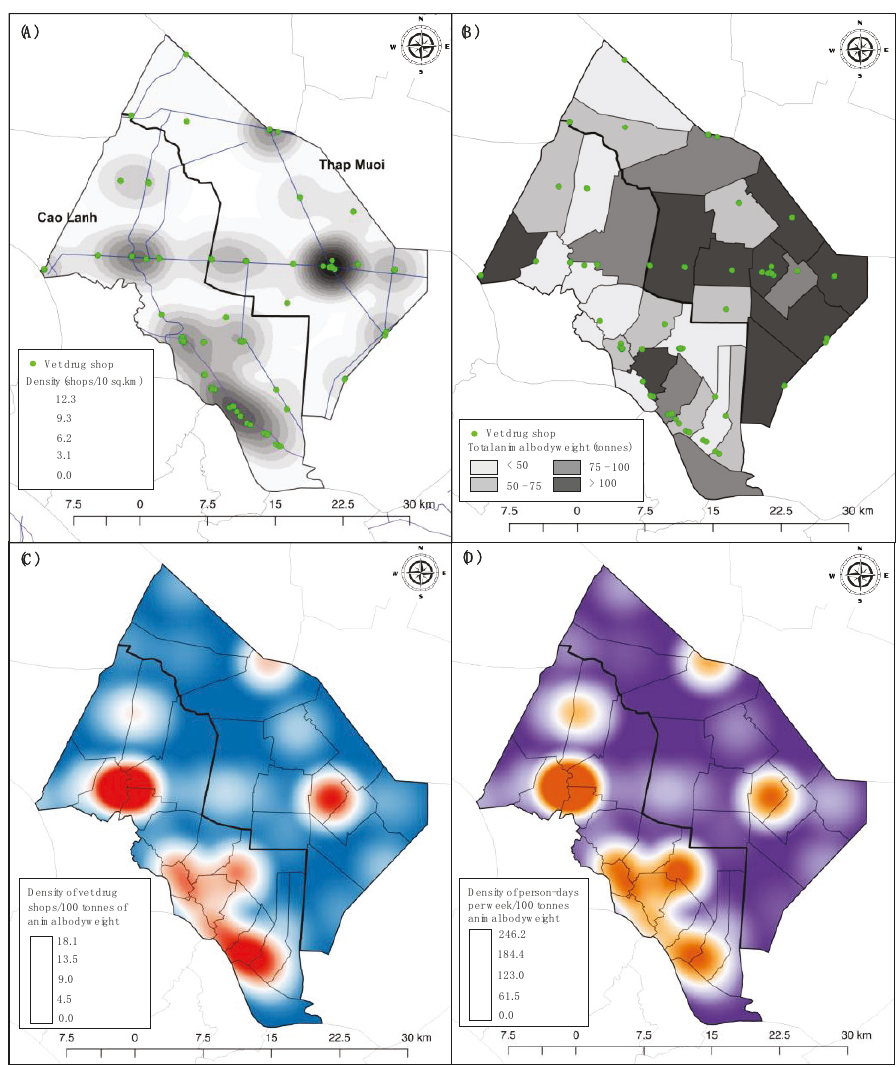
Figure 2. Geographical distribution of veterinary drug shop and livestock density at commune level in the study area. ( A ) Geographical distribution and kernel density of veterinary drug shops within an area of 10 km 2 ; ( B ) density of animal populations by commune expressed as animal bodyweight, and location of veterinary drug shops; ( C ) density heat map displaying the number of veterinary drug shops per 100 tonnes of animal bodyweight; ( D ) density heat map of staffing capacity (person-days/week) per 100 tonnes of animal bodyweight.